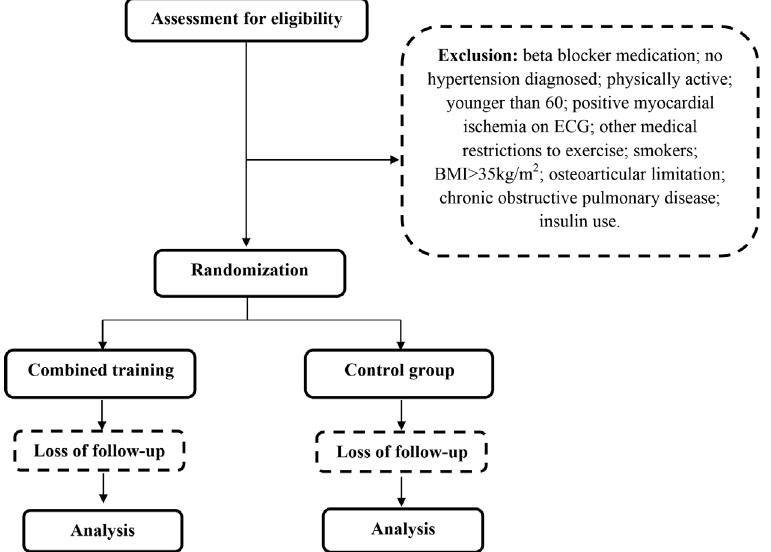
Figure 3. Flowchart of the participant`s